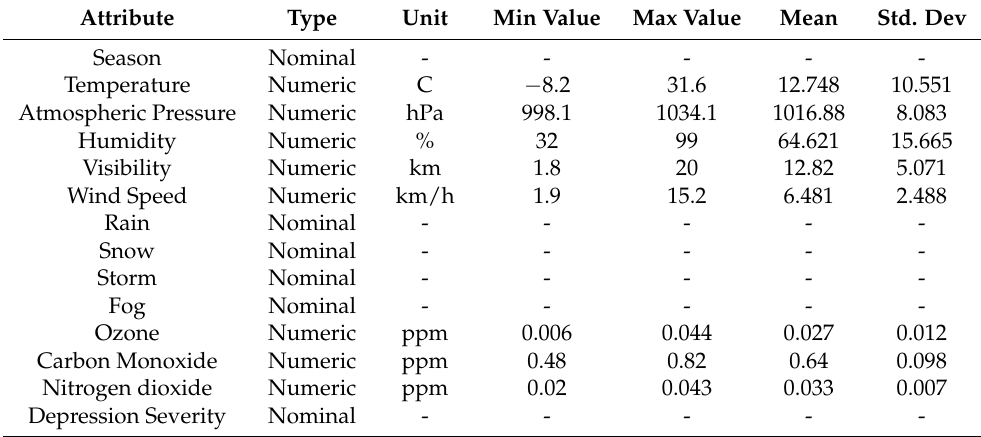
Table 4. Profile information of dataset used for depressive disorder analysis. Min Value and Max Value are the Minimum and Maximum values in the dataset. Std. Dev is the standard deviation.